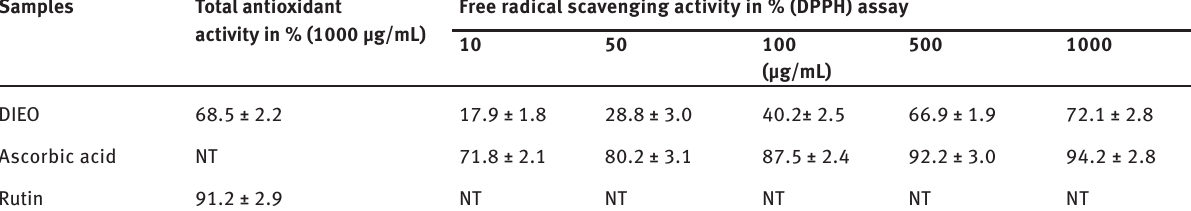
Table 4: Antioxidant and free radical scavenging activities of the D. ismaelis essential oil (DIEO). Samples